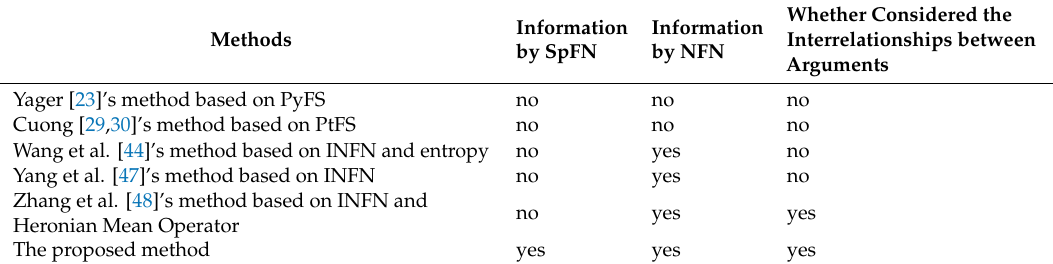
Table 5. The characteristic comparisons of di ff erent